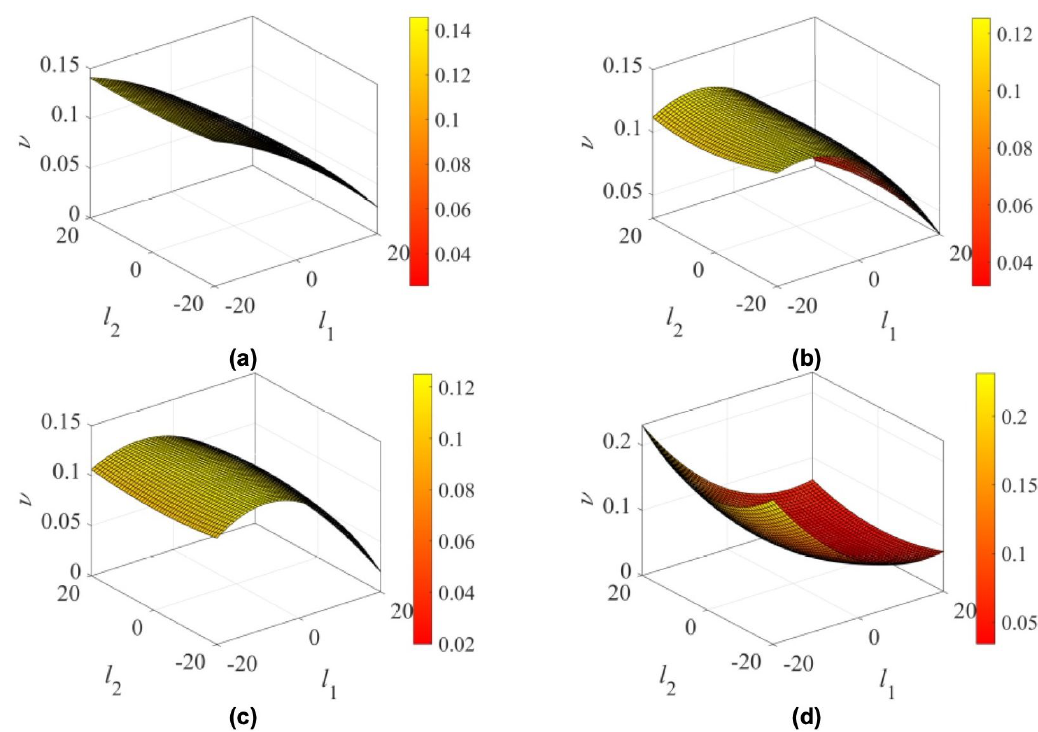
Figure 11: Pressure mode #1 for rectangular plan with θ = 90 ∘ and geometry G 5 (a), G 6 (c), G 7 (b), G 8 (d), referring to Table